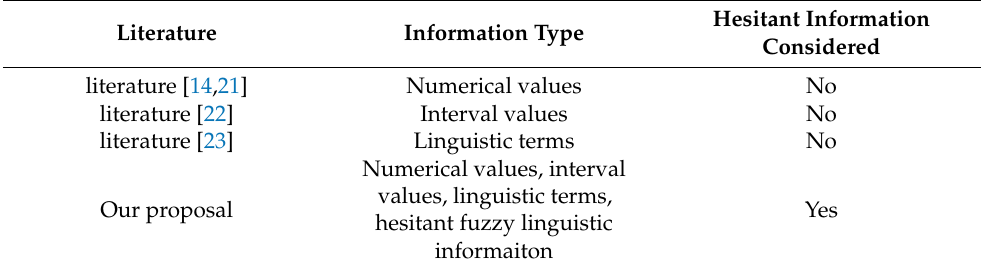
Table 16. Descriptive comparison with existing